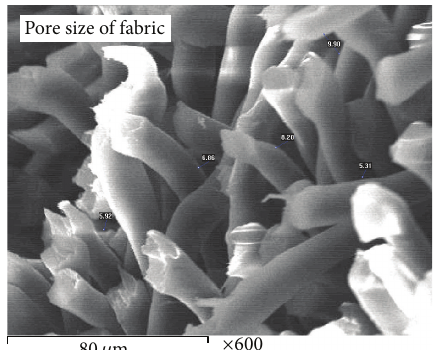
Figure 1: SEM of polyester fabric.